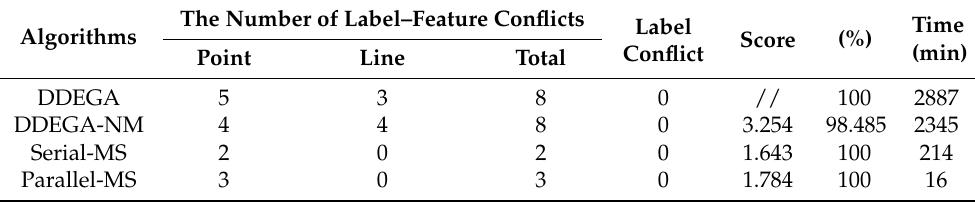
Table 5. Comparison of the proposed algorithm with previous algorithms on the second dataset. Algorithms